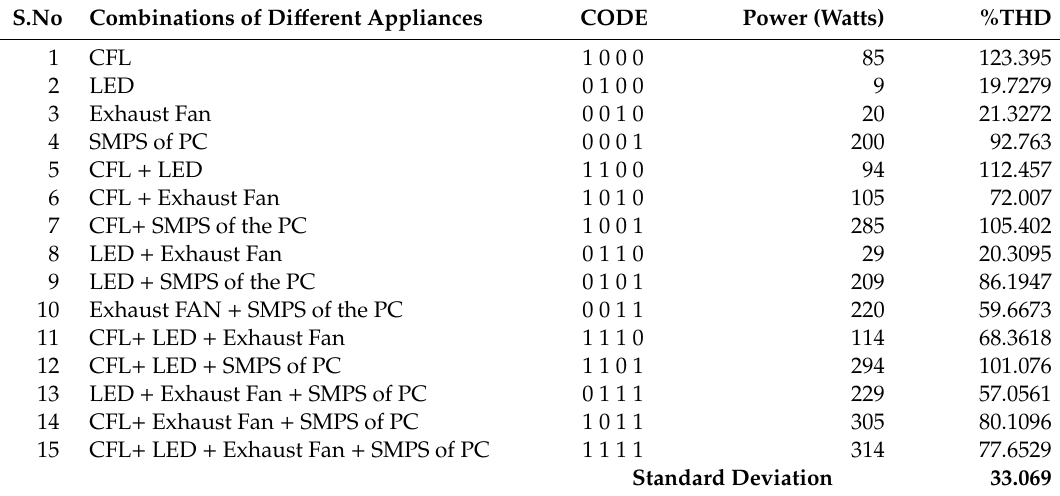
Table 2. Percentage THD for all 15 load patterns in real time.